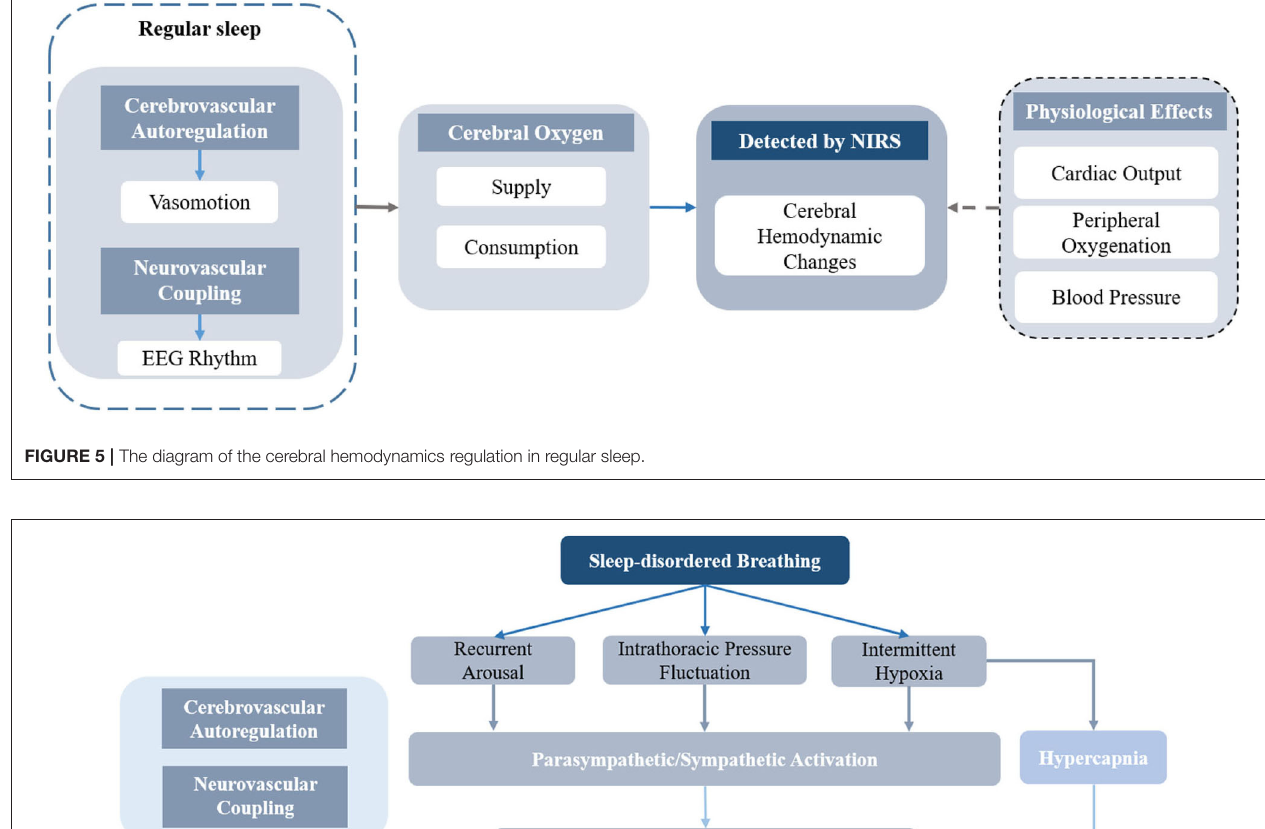
of HbO 2 and HHb are associated with regulated vasomotion (25, 26, 56, 108), and the fluctuations of HbO 2 and HHb induced by SDB are partially related to cerebral vasomotor